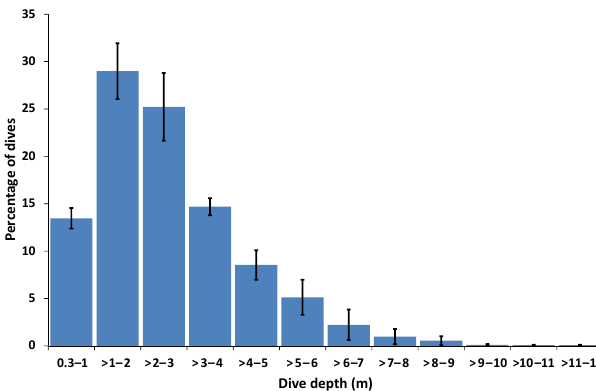
Figure 4. Dive depths of northern gannets in 2015. Data are based on 2557 dives recorded from four adults breeding on Heligoland. Vertical bars show values averaged over the four individuals; ex- tended lines show standard errors. Immersions of <0.3m were ex- cluded as potentially indicating bathing and other